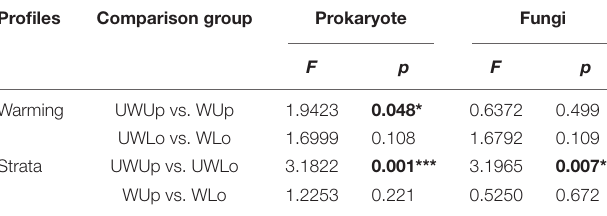
TABLE 1 | Effects of warming and strata on microbial